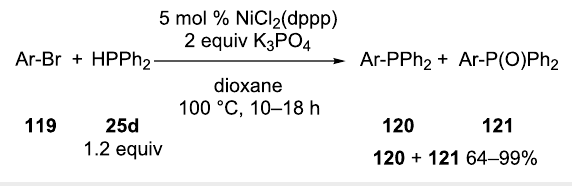
Scheme 34: Nickel-catalyzed cross-coupling between aryl bromides 119 and diphenylphosphine ( 25d ) (dppp = 1,3-